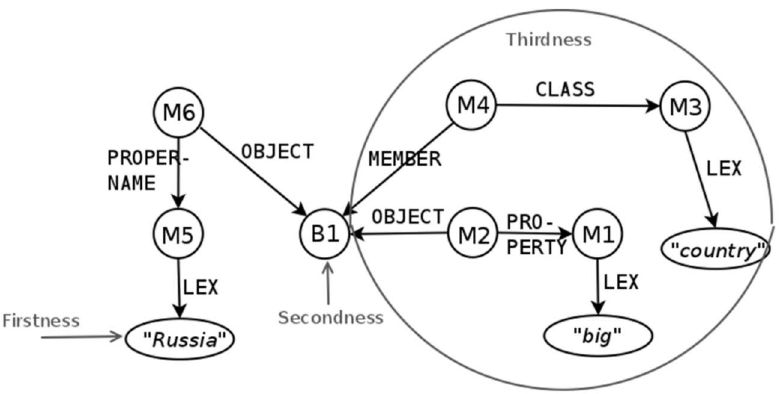
Figure 2. Semantic network representing the content of the sentence “Russia is a big country”